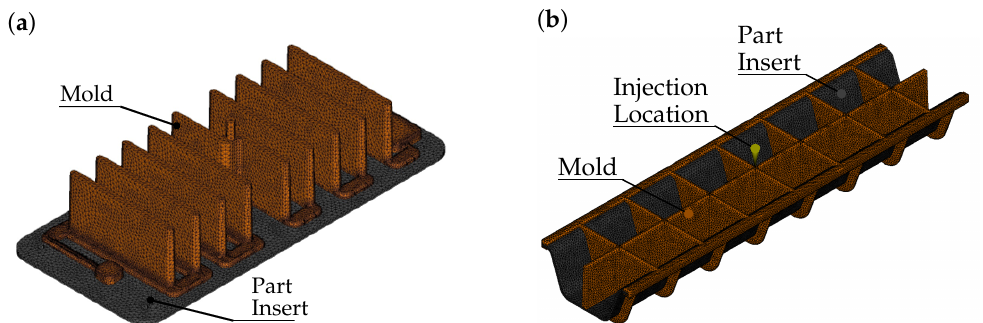
Figure 3. Simulations models used: ( a ) Tetrahedral mesh of the rib structure ( b ) Tetrahedral mesh of the virtual demonstrator structure.